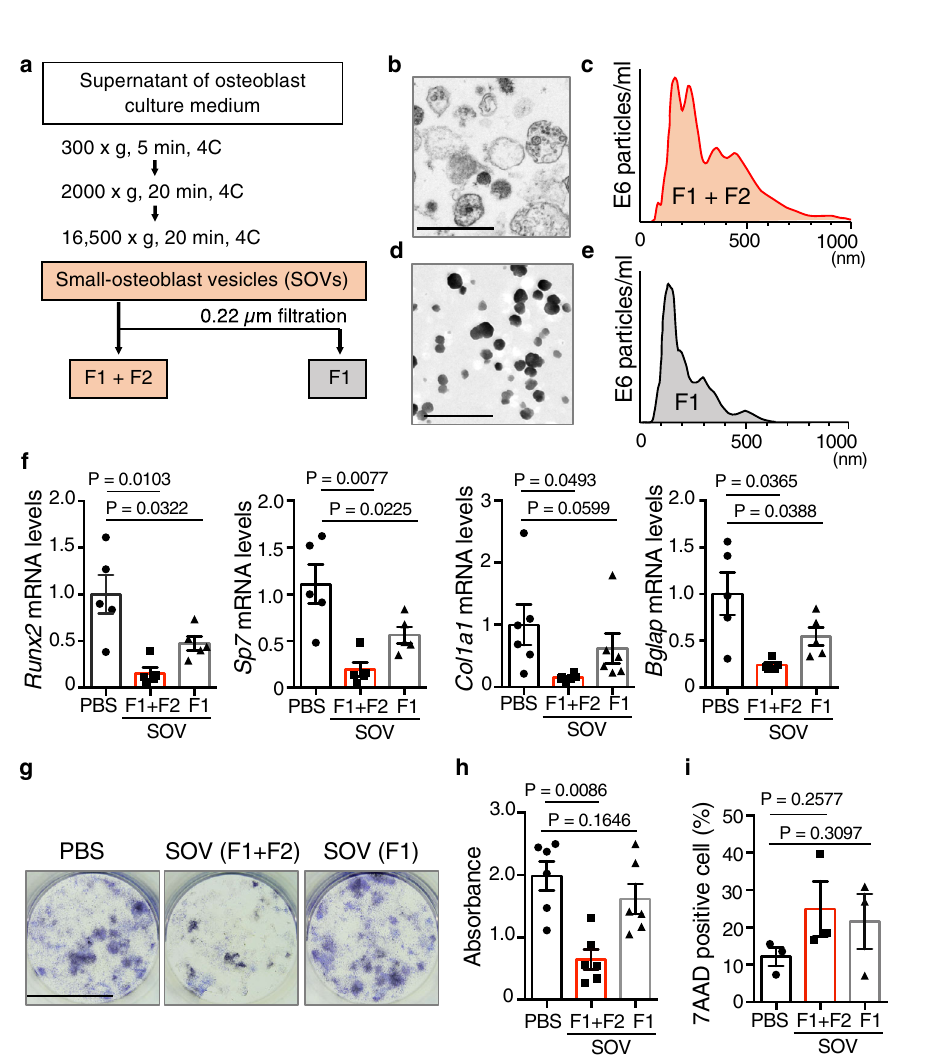
Fig. 1 Communication among osteoblasts via small osteoblast vesicles in vivo and in vitro. a Schematic representation of mouse skull bone (left) and an intravital multiphoton, maximum-intensity projection image of skull bone tissues from Col2.3-ECFP mice (a representative image, at least three independent experiments) (right). Cyan: mature osteoblasts (mOBs) and extracellular vesicles (EVs) from mOBs; blue: bone surface, second harmonic generation. Scale bar: 20 μ m. b Three-dimensional image of visual fi eld shown in ( a ). Arrowhead indicates an EV. Scale bar: 20 μ m. c Magni fi ed view of region outlined in ( a ). Arrowheads indicate EVs. Scale bar: 10 μ m. d Speed of mOB-derived EVs by tracking analysis of EVs shown in ( c ) ( n = 51). SOVs: small osteoblast vesicles with a diameter of ≤ 1 µ m; LOVs: large osteoblast vesicles with a diameter of >1 µ m. e Consecutive time-lapse images of SOVs released by mOBs indicated by yellow lines in ( c ). Arrowheads and dotted lines indicate SOVs and their tracks, respectively. Scale bar: 5 µ m. f Consecutive time-lapse images of SOVs taken up by mOBs indicated by dotted lines in ( c ). Arrowheads and dotted lines indicate SOVs and their tracks, respectively. Scale bar: 5 µ m. g , h Representative images of primary osteoblasts of Col2.3-ECFP mice of at least three independent experiments. Cyan: mOBs and mOB- derived EVs. Scale bar: 20 µ m. i Consecutive time-lapse images of released SOVs indicated by yellow lines in ( g ). Arrowheads and dotted lines indicate SOVs and their tracks, respectively. Scale bar: 10 µ m. j Consecutive time-lapse images of internalized SOVs indicated by dotted lines in ( h ). Arrowheads and dotted lines indicate SOVs and their tracks, respectively. Scale bar: 10 µ m.